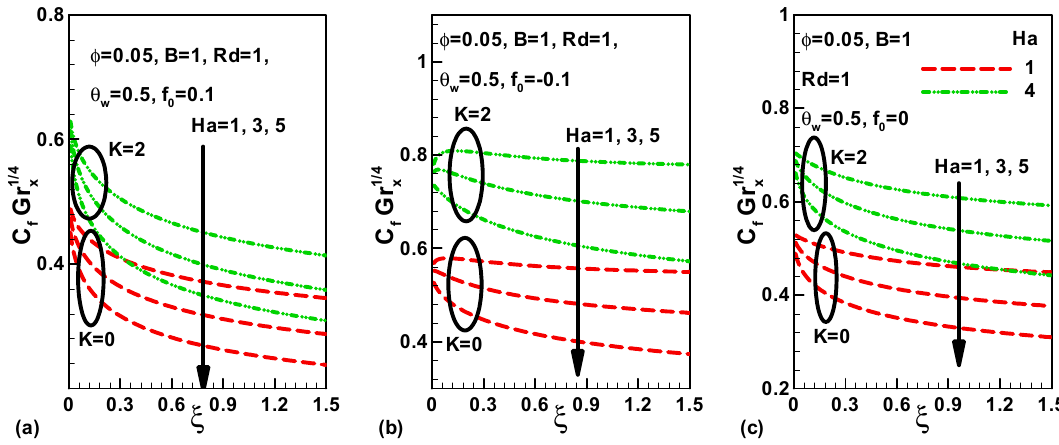
Figure 8. Effects of magnetic and micropolar parameters on skin friction along truncated cone for ( a ) suction, ( b ) injection, and ( c ) impermeable of kerosene-based magnetite nanofluid.